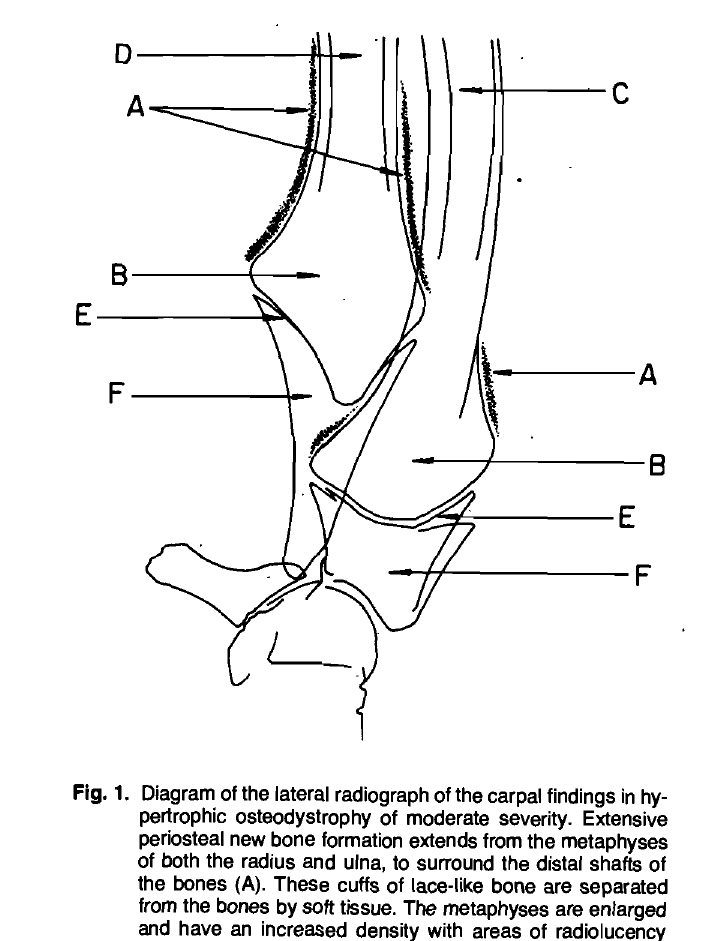
Fig. 1. Diagram of the lateral radiograph of the carpal findings in hy pertrophic osteodystrophy of moderate severity. Extensive periosteal new bone formation extends from the metaphyses of both the radius and ulna, to surround the distal shafts of the bones (A). These cuffs of lace-like bone are separated from the bones by soft tissue. The metaphyses are enlarged and have an increased density with areas of radiolucency (8). Normal appearing diaphysis of the radius (C), diaphysis of the ulna (D), growth plates (E), and epiphyses (F).